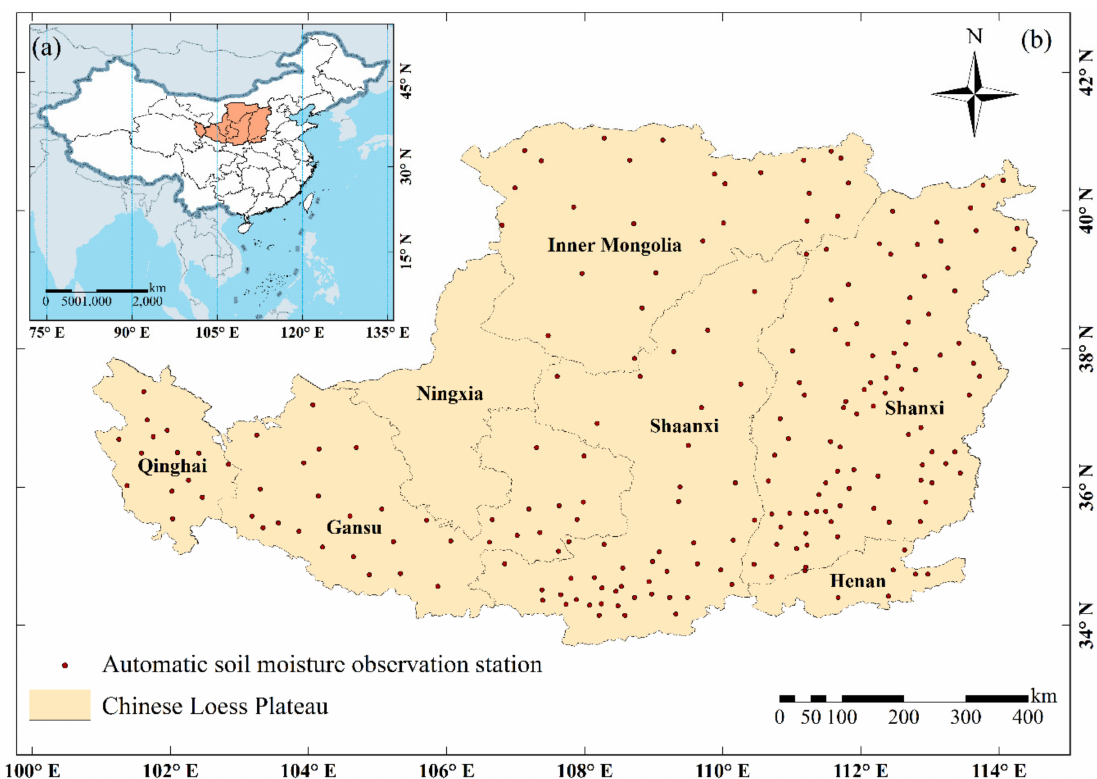
Figure 1. Study area. ( a ) The Location of the Chinese Loess Plateau in China, ( b ) 213 automatic soil moisture observation stations in the Chinese Loess